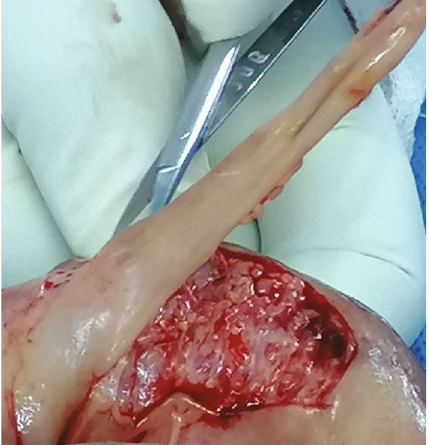
Figure 3: Oral mucosa graft being harvested from the lower lip.